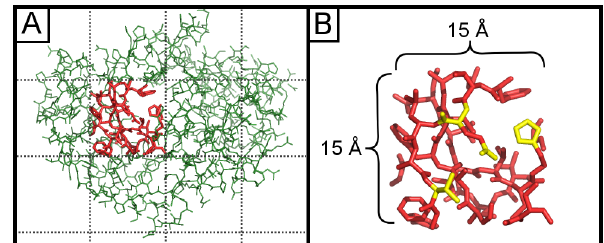
Figure 2. Subdivision of protein structures. (A) An interior page highlighted in red from a protein of unknown function (PDB ID = 2FSQ), illustrating the maximum scale of search queries. (B) Example words (chemical motifs) within the same page highlighted in